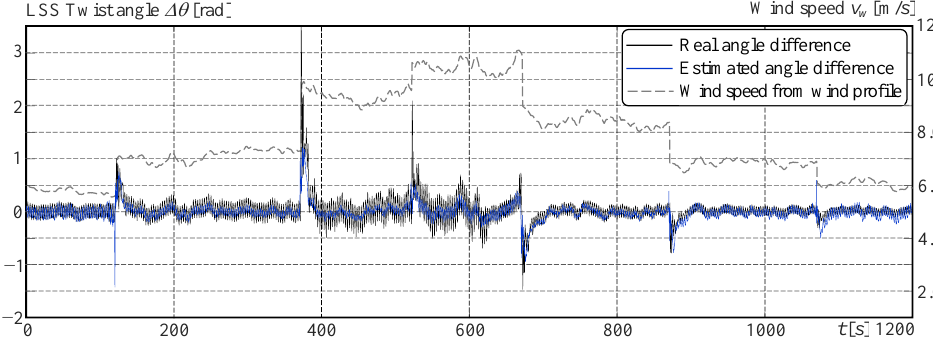
Figure 13. Time series of the twist angle of the slow-speed shaft.